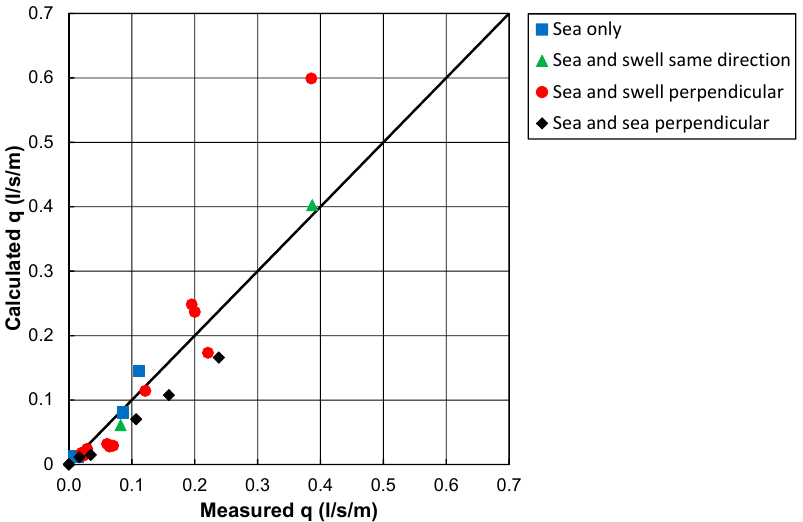
Figure 7. Measured versus calculated wave overtopping, using Equation (13).